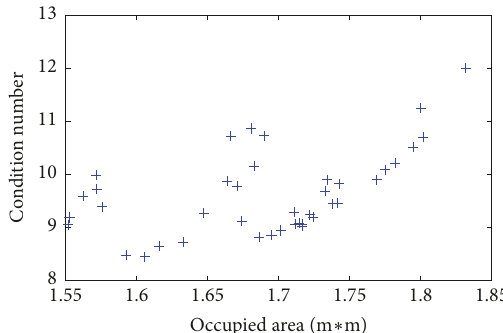
Figure 7: Scatter plot of occupied area and condition